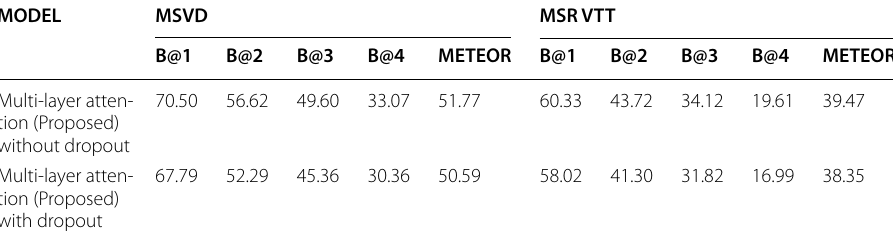
Table 4 Performance score with tuned parameters MODEL